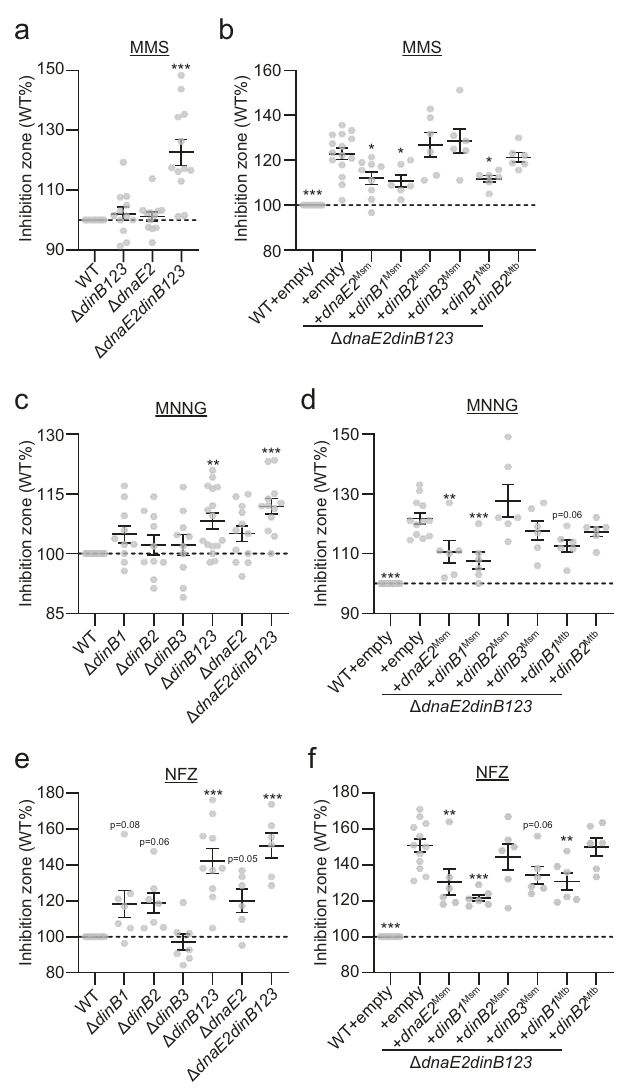
Fig. 4| RedundancyofDinB1andDnaE2 intolerancetoalkylationdamageand N 2 -dGadducts. Sensitivitiesofindicatedstrainsto a and b MMS, c and d MNNG,or e and f NFZ were measured by disc diffusion assay. Translesion polymerases were expressed under their native promoter from a genome integrated vector in panels b , d , and f . Results shown are means (±SEM) of data obtained from biological replicates symbolized by gray dots. Stars above the means mark a statistical dif- ference with the reference strain (WT or Δ dnaE2dinB123 +empty in com- plementation experiments) (*, P <0.05; **, P <0.01; ***, P <0.001). p values were obtained on log-transformed data by one-way ANOVA with a Bonferroni